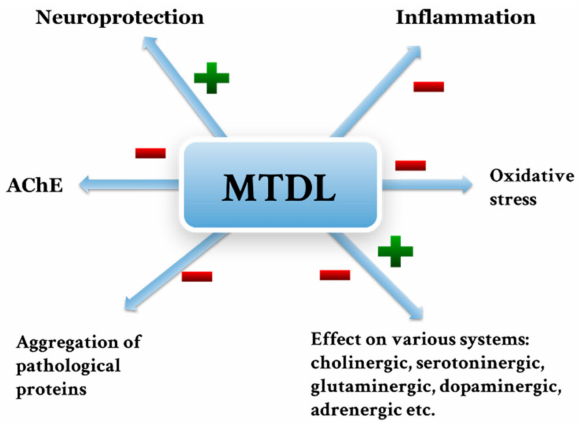
Figure 3. Strategies for MTDLs. “ − ”—inhibitory effect; “+”—beneficial